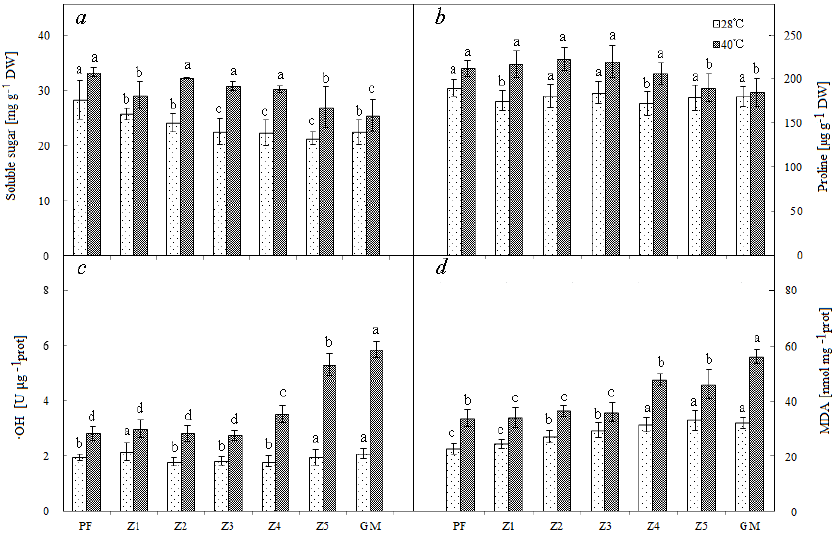
Figure 3. Soluble sugar ( a ), proline ( b ), · OH ( c ), and MDA ( d ) of different materials. Note: PF—purple female; GM—green male. Lowercase means significance at 0.05 levels. Means of 10 replica- tions ± SE.